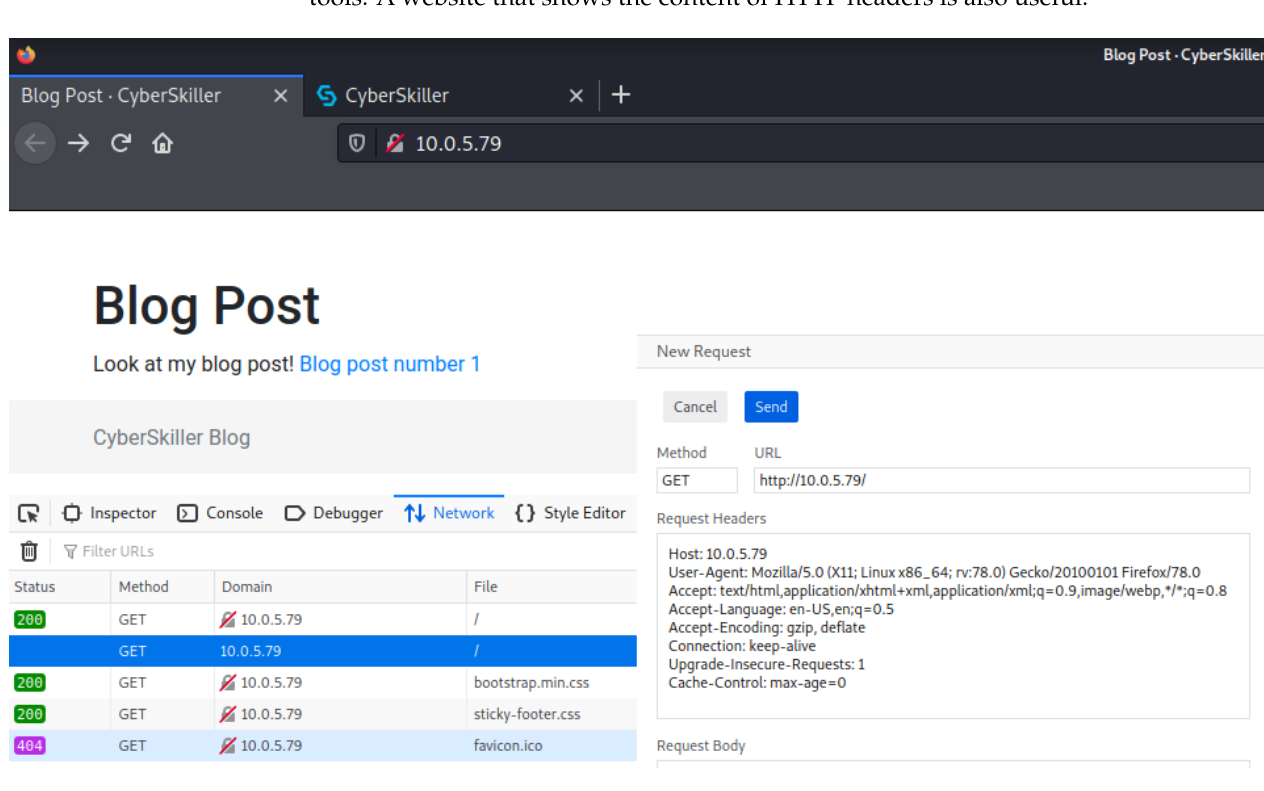
Figure 1. Exercise 1.5: Modification of HTTP Requests (⋆)